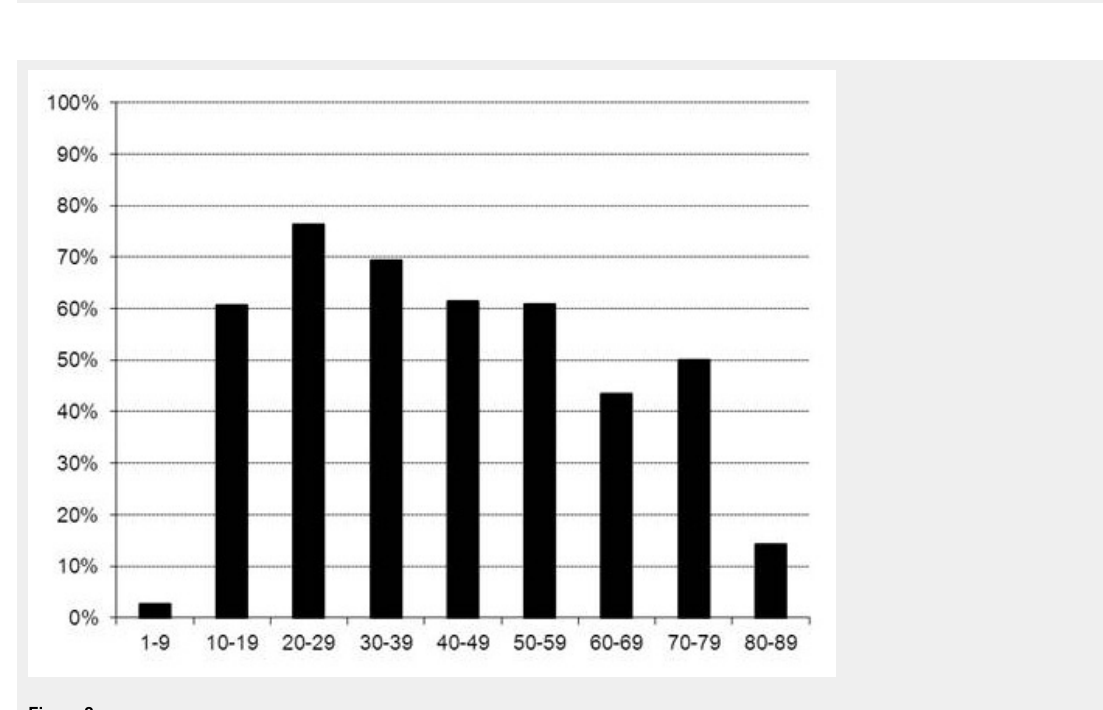
Figure 1 Percentage of open versus laparoscopic appendectomies.